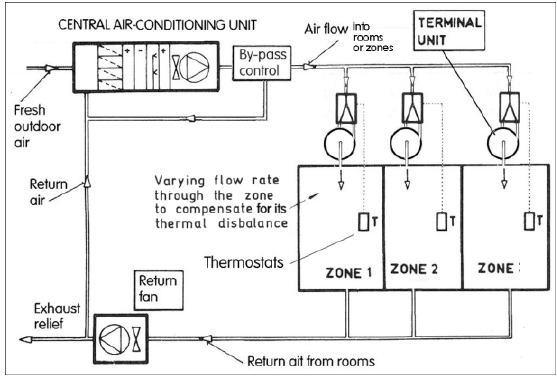
Fig. 17. Representation of thermal control in a building with all-air system using oscillating bistable turn-down vortex valves in terminal units operating in variable air-flow pulse width mode.– compare with Fig. 16.